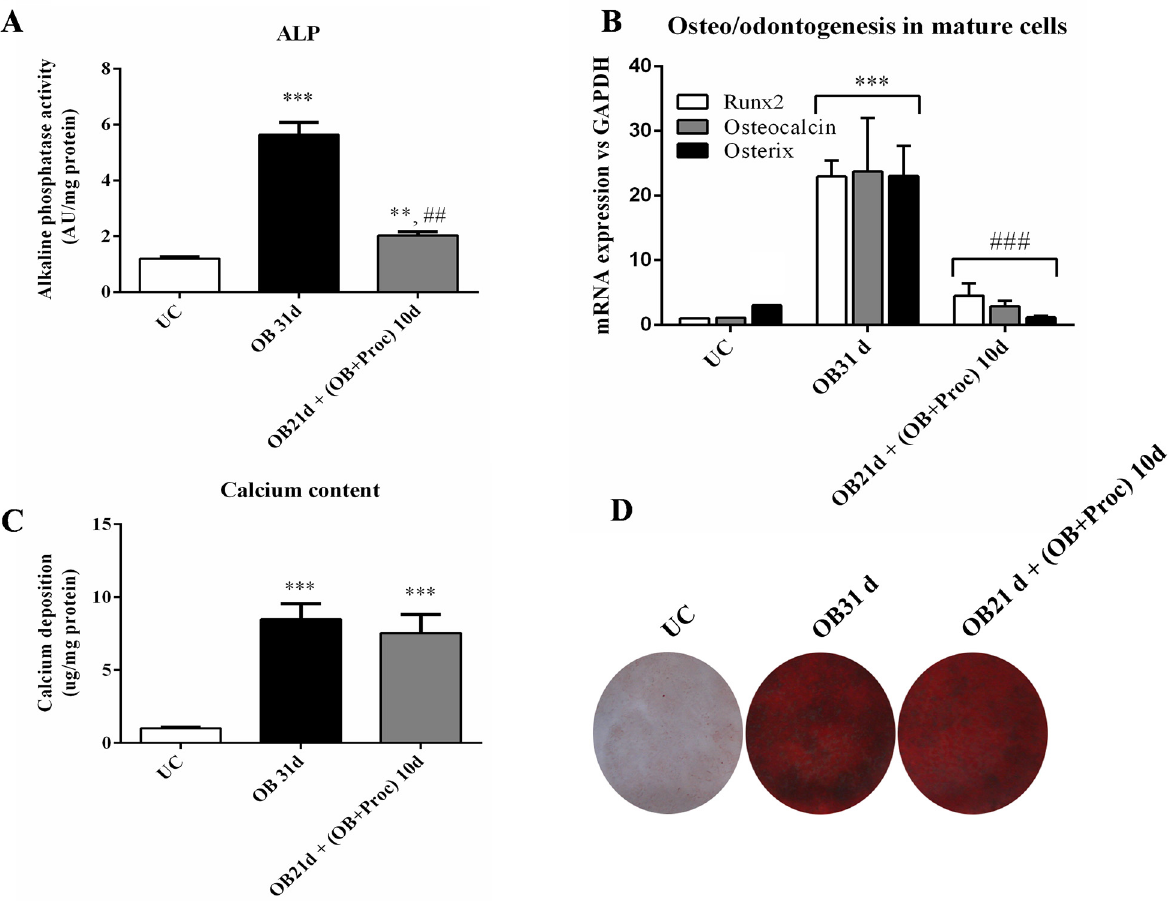
Fig 7. Procaine also promotes changes on mature osteo/odontoblasts. Procaine addition for 10 days to differentiated osteoblasts cells from MSC for 31days led to a decrease in A) alkaline phosphatase activity ( *** p < 0.001, ** p < 0.01 vs. undifferentiated cells (UC) and ## p < 0.01 vs OB cells) and B) on osteo/odontogenic genes ( *** p < 0.001 vs UC cells and ### p < 0.001 vs. OB cells). C) Calcium content and D) alizarin red staining did not change with respect to OB cells after 31 days of osteo/odontogenic stimulus and the last 10 days with procaine. Images representative of three